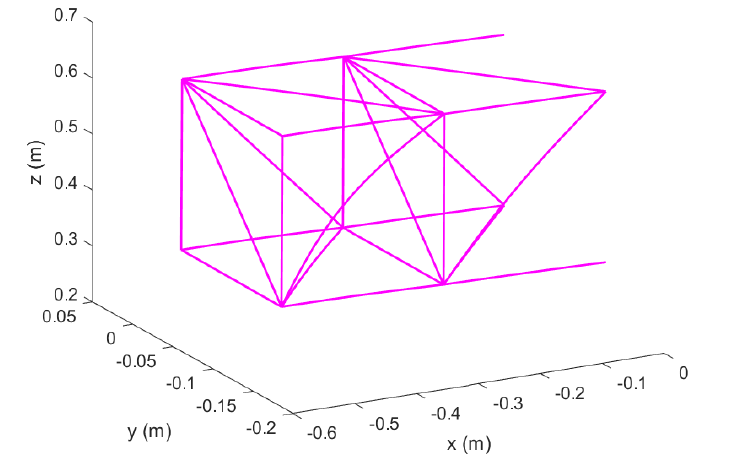
Figure 18. Mode 1 of Euler–Bernoulli Beams in Topology 1 with hinged ends; original